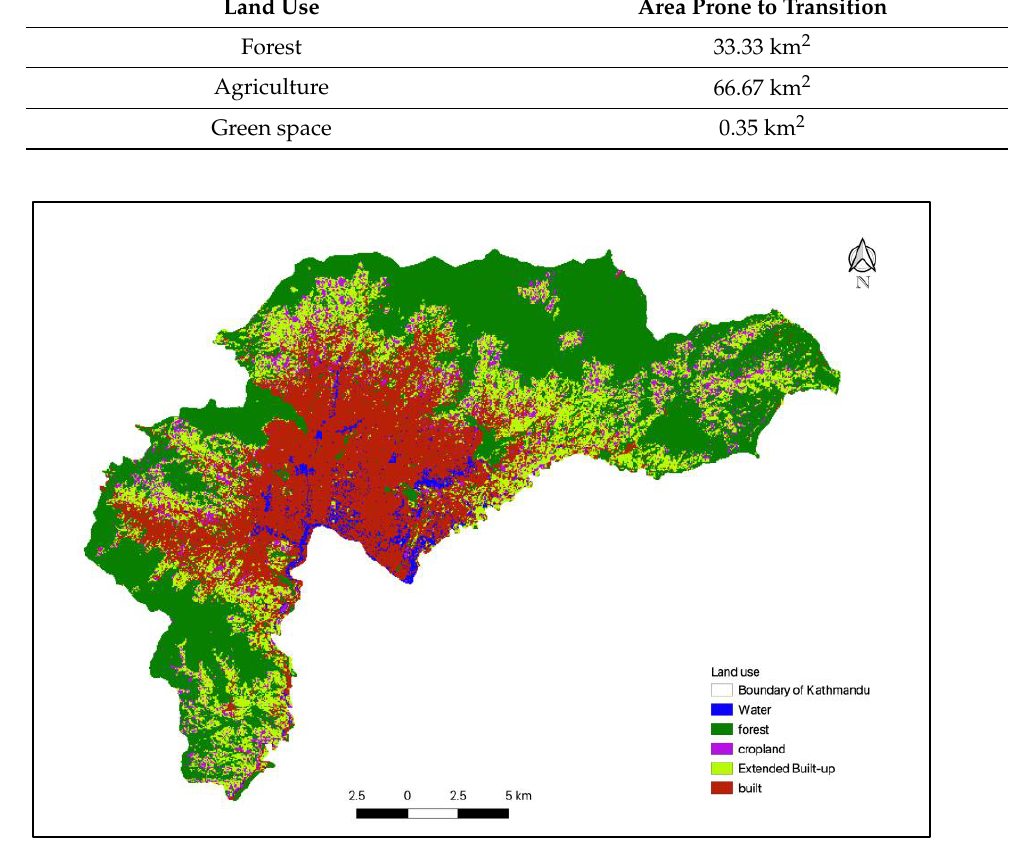
Figure 7. Probable extension of built-up areas; generated through scenario modeling. Table 9. Land-use classes prone to transition to built-up area.